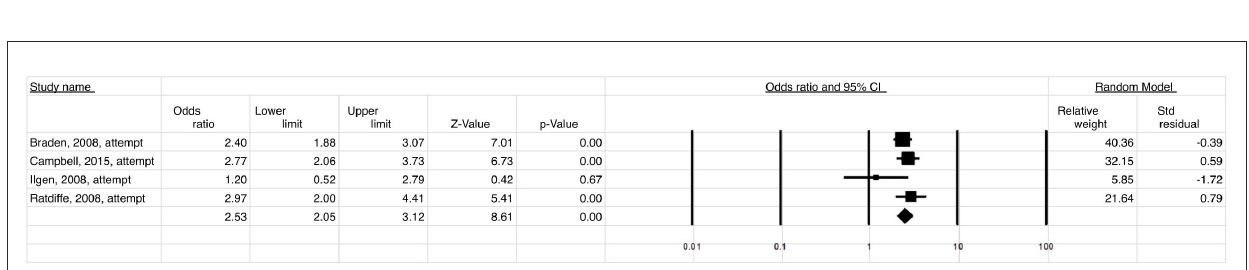
FIGURE7 Relationship between risk of suicide attempt (OR = 2.53) in patients with chronic back/neck pain when compared to healthy